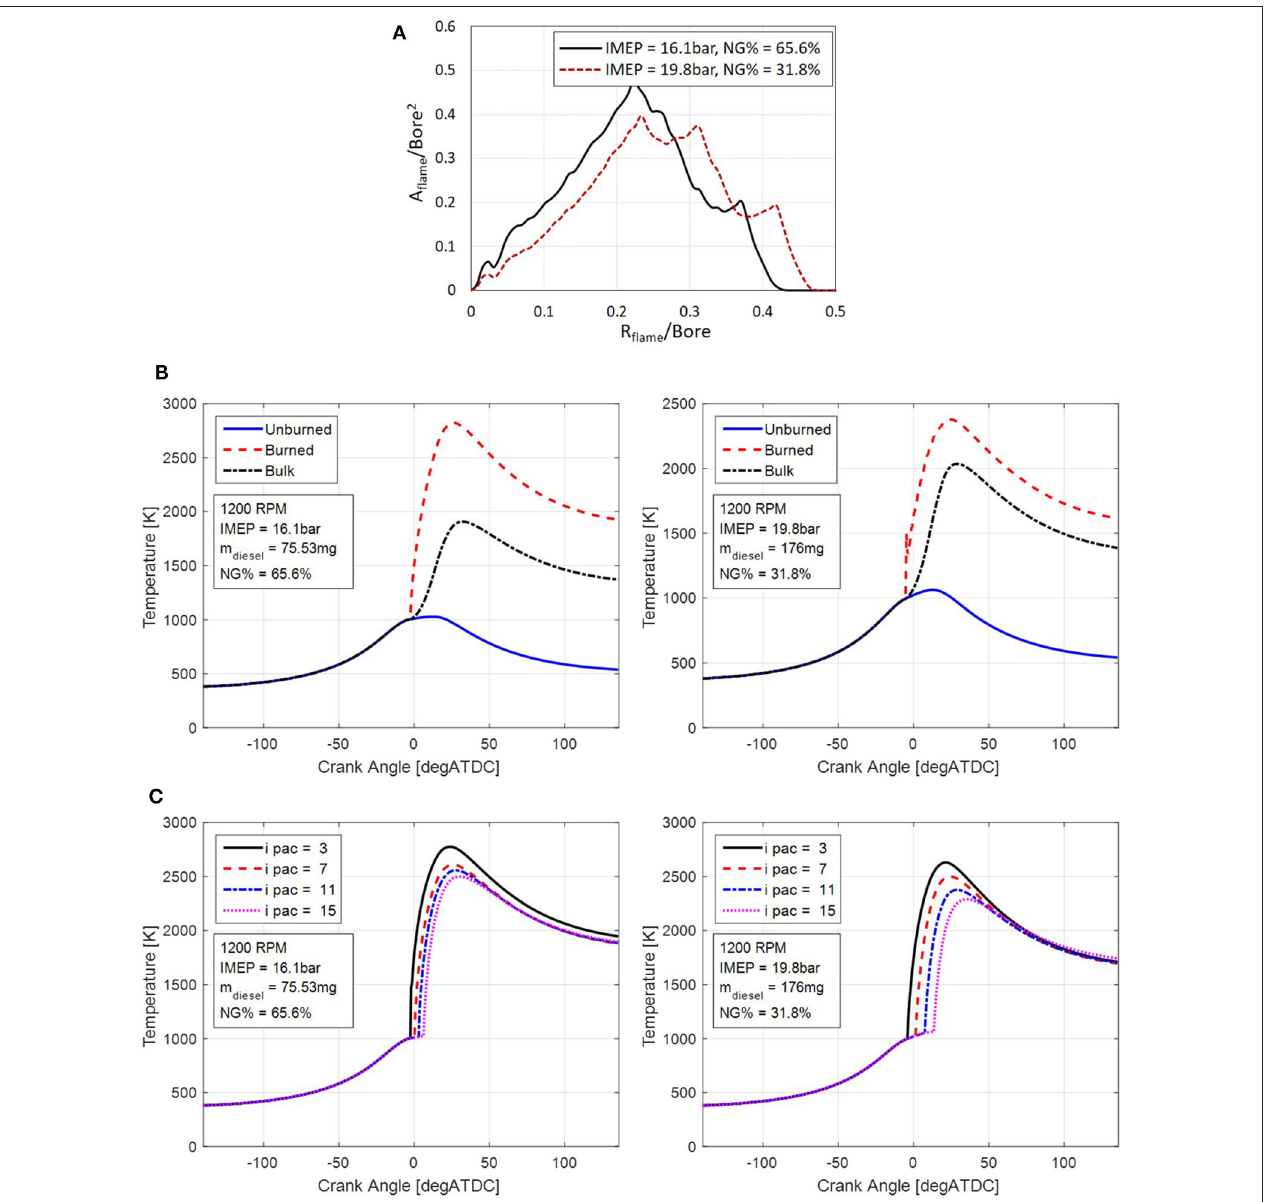
FIGURE 14 | (A) Model prediction results of NG flame front surface area. (B) Model prediction results of in-cylinder temperatures of unburned, burned and bulk gas temperatures. (C) Model prediction results of in-cylinder temperatures in individual diesel spray